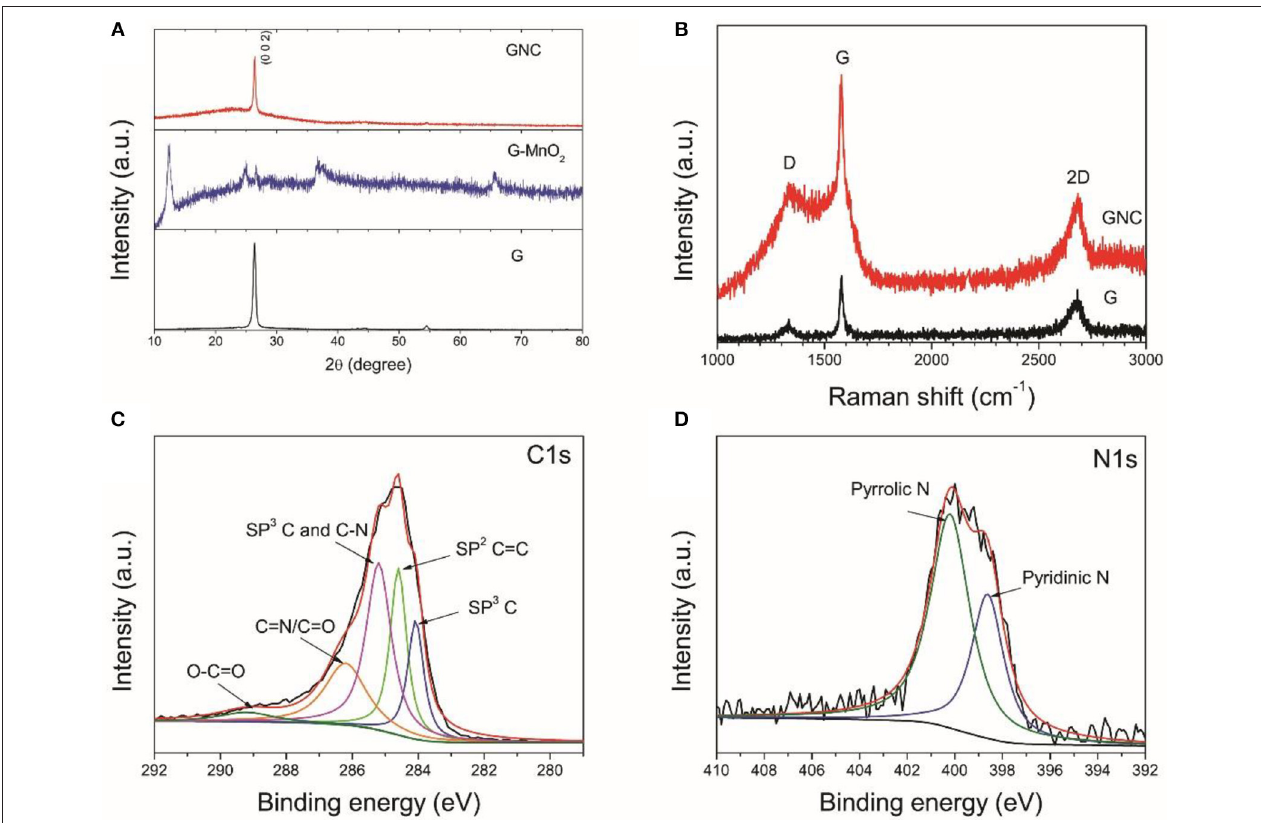
FIGURE 3 | XRD patterns of the starting graphene nanoplatelets and their composite with birnessite MnO 2 and N-doped amorphous carbon (A) , the Raman spectra of the starting graphene nanoplatelets and GNC (B) , the XPS C1s (C) , and N 1s (D) core scans of